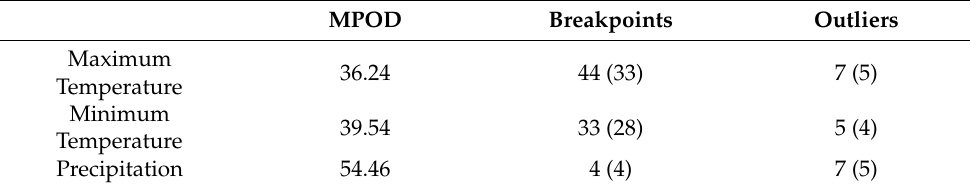
Table 4. The mean of percentage of original data (MPOD), the total number of breakpoints, and outliers, are shown as a result of the homogenization process of maximum and minimum temperature, and precipitation. The numbers in parentheses show the number of stations that presented those breakpoints and